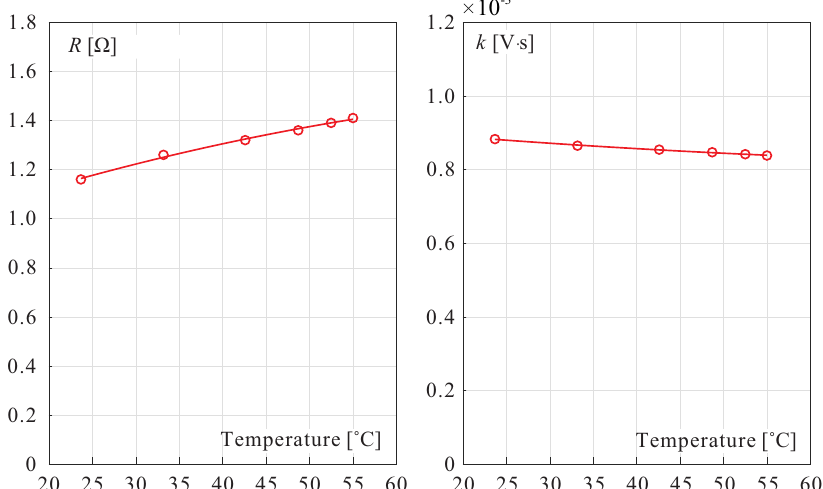
Figure A1. Evolution of the internal resistance R (left) and the motor constant k with the motor M2 housing